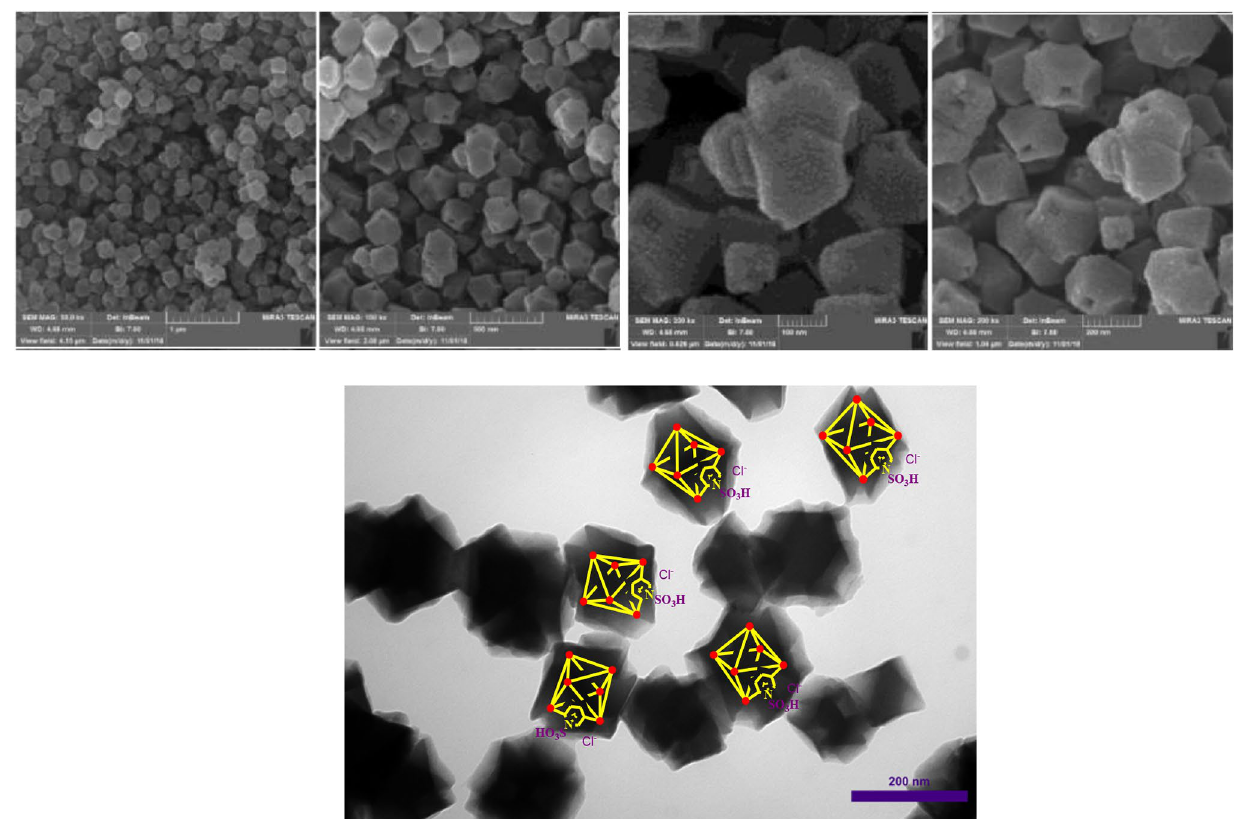
Figure 5. Up: Field-Emission Scanning electron microscopy (FE-SEM) images of [Zr-UiO-66-PDC-SO 3 H]Cl. Down: Transmission electron microscopy (TEM) micrograph of [Zr-UiO-66-PDC-SO 3